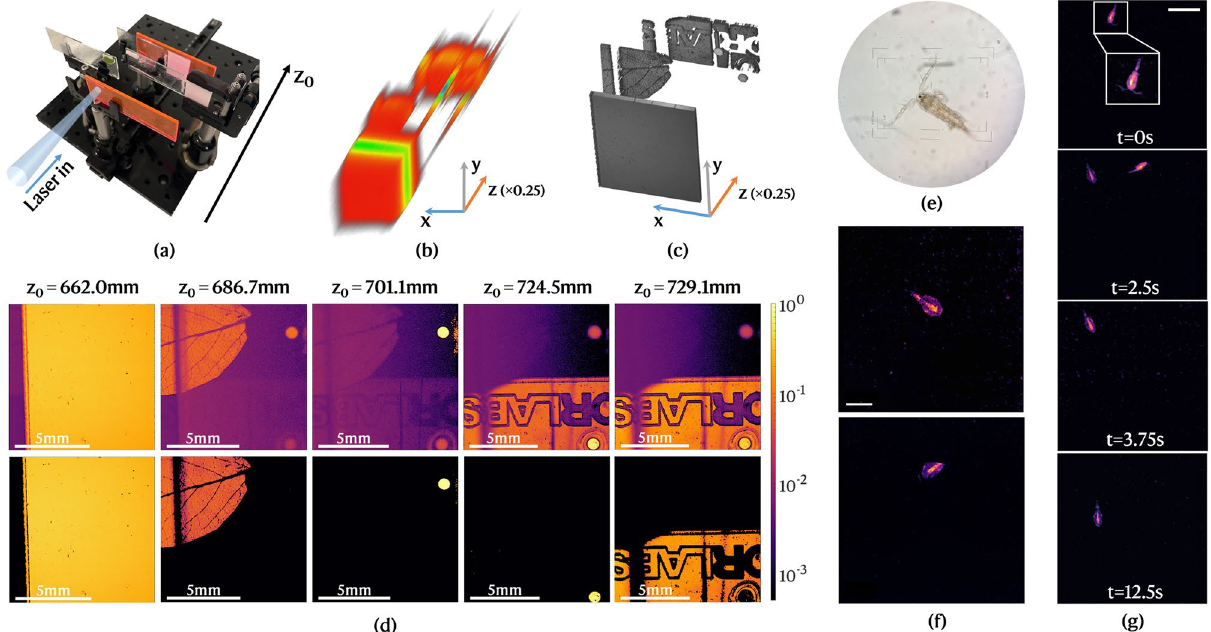
Figure 4. Underwater confocal LiDAR imaging demonstration. ( a ) Photography of the artificial 3D scene assembled. ( b ) 3D point cloud built from the raw stack of confocal images. The z-scale is contracted by a factor of 4. ( c ) Volumetric render of the scene after subtraction of out-of-focus contributions. ( d ) Montage of the best focus images for each layer in a logarithmic fluorescence intensity scale. On the top row, the raw slices; on the bottom, the same slices after correction. Each image has a 600 × 600 resolution and 16-bit depth ( ∼ 7 μs pixel dwell time). ( e ) An Acocyclops royi copepod viewed under a bright-field microscope with 10 × magnification. ( f ) Two examples of underwater autofluorescence images of free-swimming copepods acquired with the LiDAR system at z 0 ∼ 587 mm. 600 × 600 image resolution, 5.9 μm pixel size, 5.5 μs dwell time. Scale bar: 500 μm. ( g ) Sequential monitoring of copepods over time. Selection of four 500 × 500 illustrative images (9.4 μm pixel size, 5 μs dwell time). Scale bar: 1